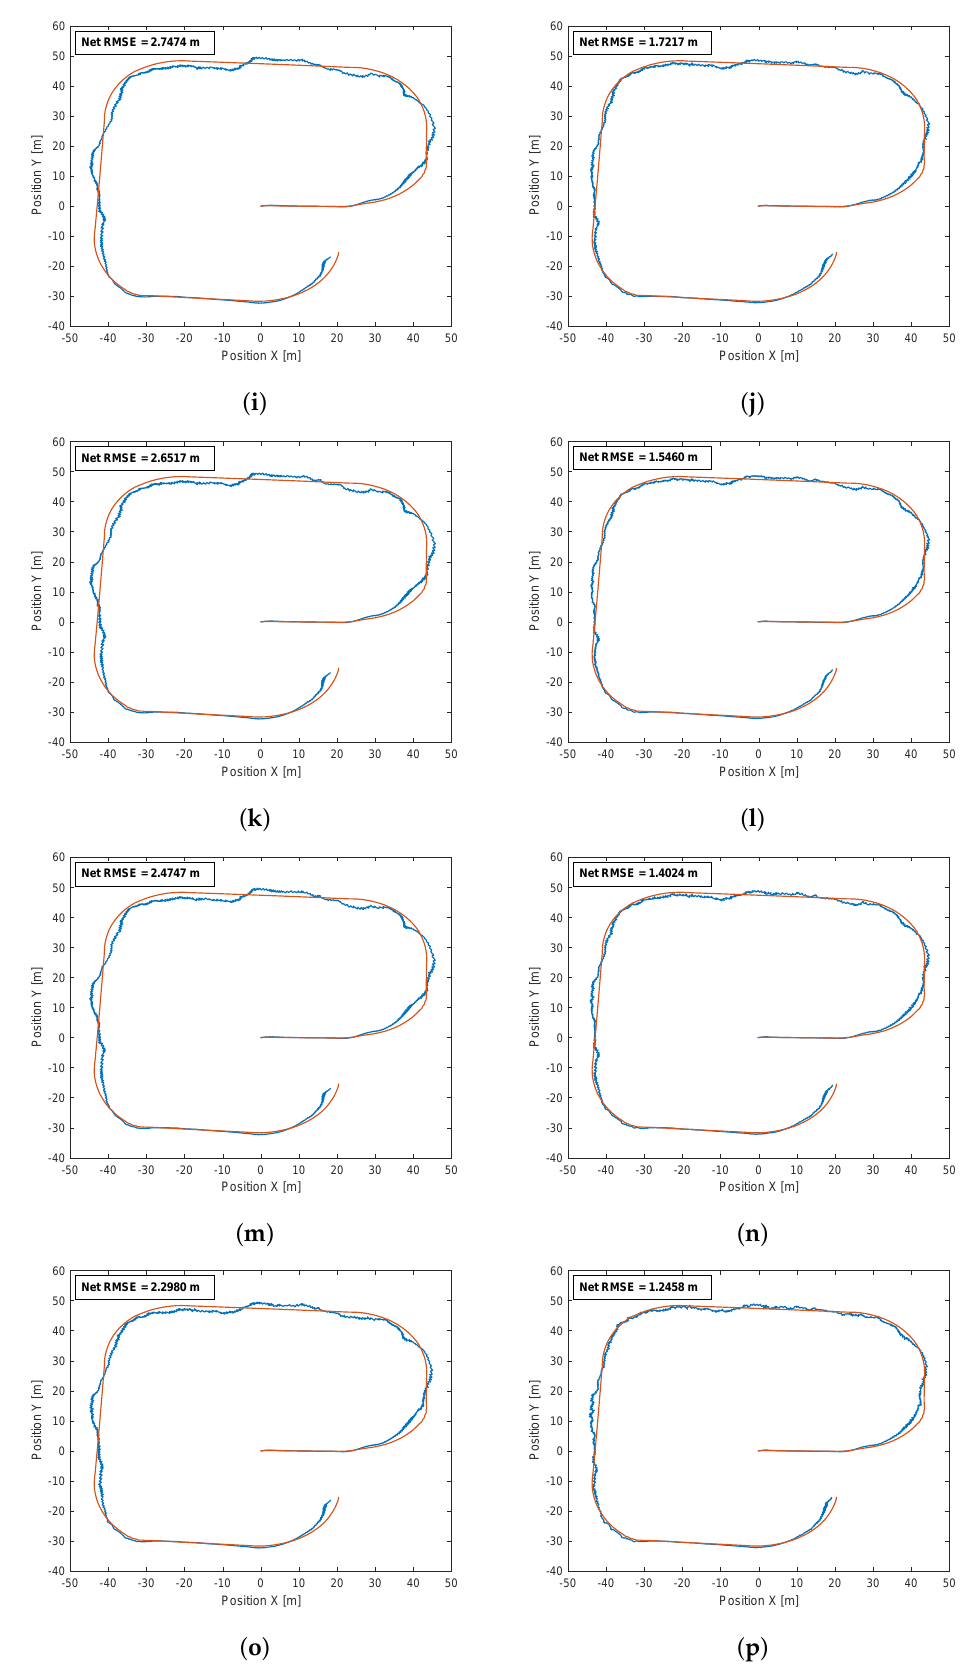
Figure 7. The IMU + Odometry estimation method yields for both EKF and UKF an RMSE over 70